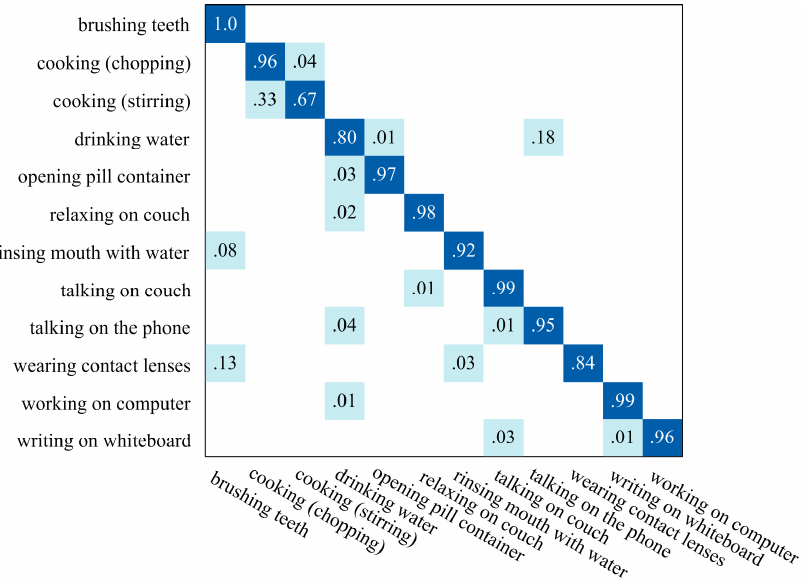
Figure 8. The average confusion matrix for recognition results of all data sequences in CAD-60. Table 1. Comparison of continuous human action recognition results on CAD-60 dataset.